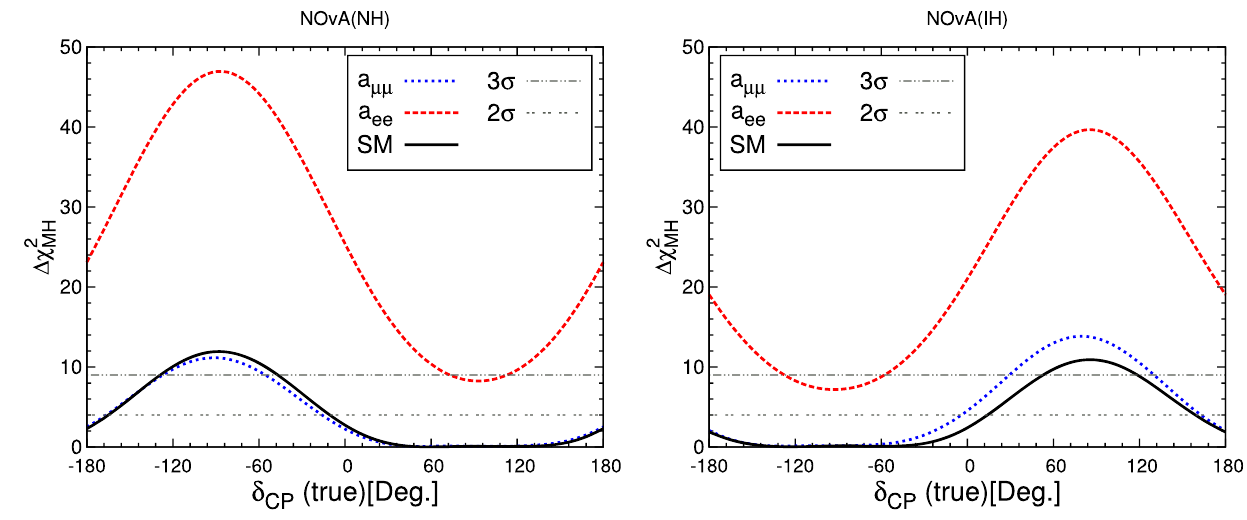
Red and blue dotted curves represent the sensitivity in the presence of diagonal parameters a ee , and a μμ respectively